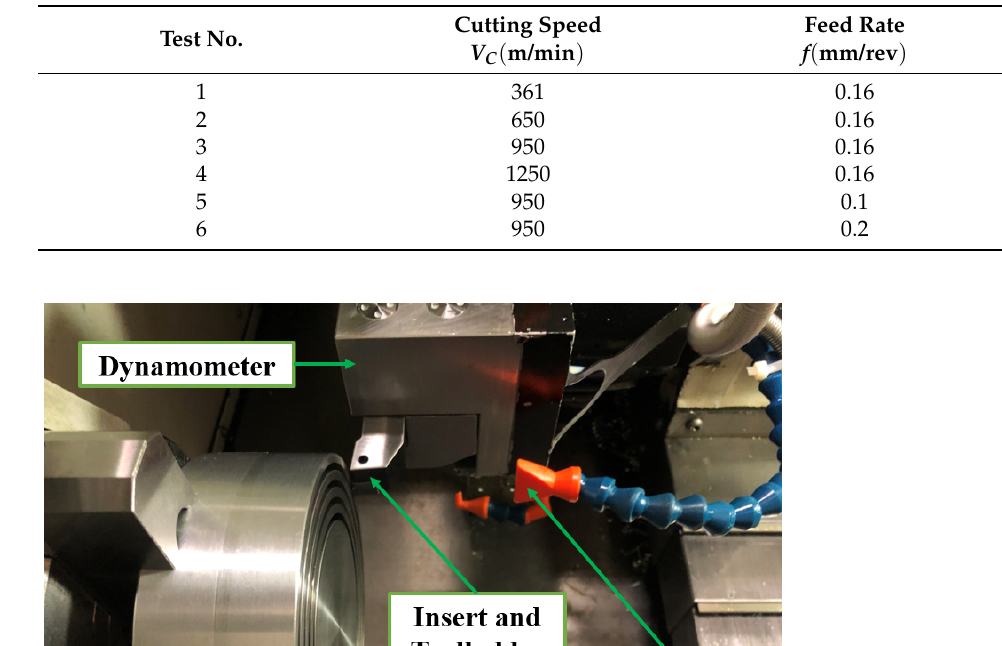
Table 1. Cutting conditions for tool geometry including (cid:1870) (cid:3081) = 0.02 mm, (cid:2011) (cid:3042) = 17.5°, and (cid:2009) (cid:3042) = 7°. Test No.